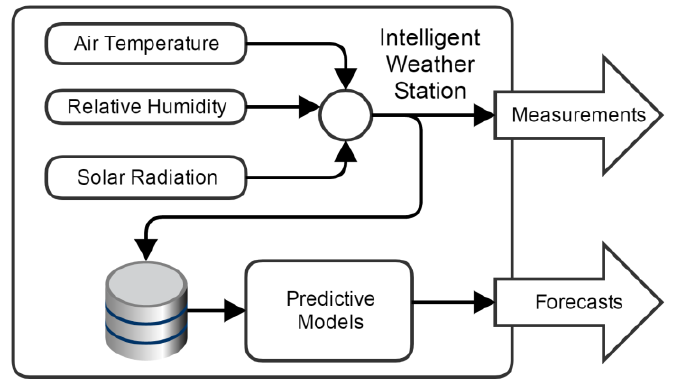
Figure 1. Simplified weather station signal-flow diagram.